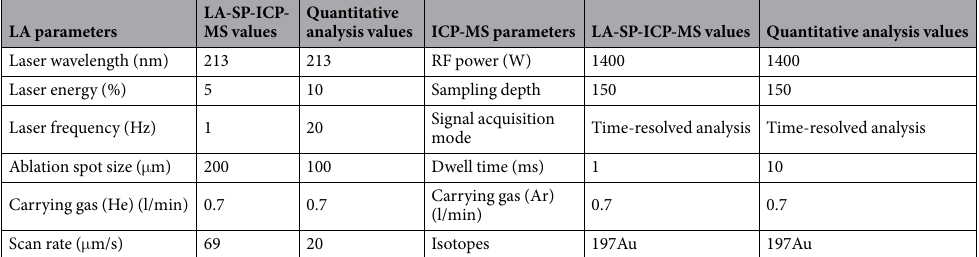
Table 1. Optimised conditions for LA-SP-ICP-MS and quantitative